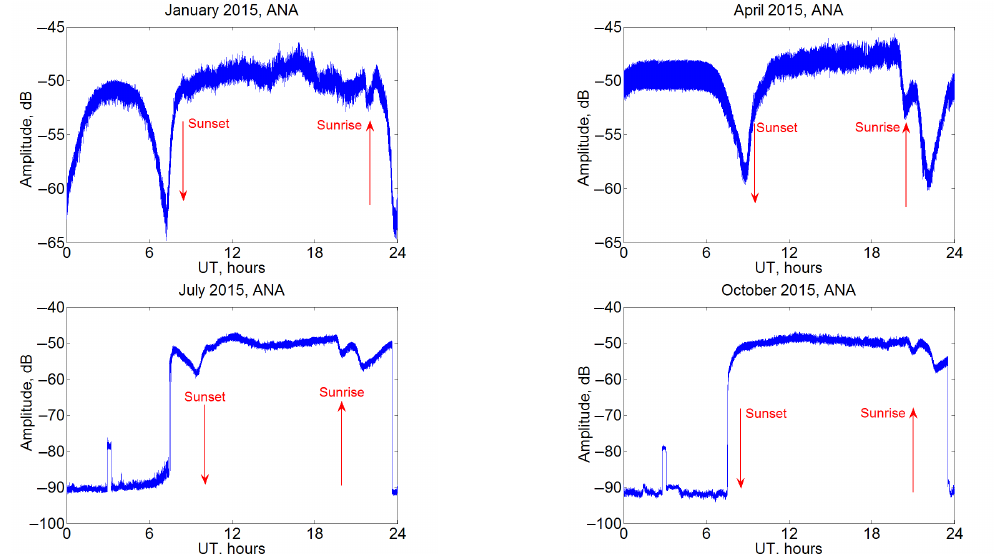
Figure 2. Monthly average variations of JJI VLF amplitudes at the ANA station in January, April, July and October 2015; median values for each second for all days of the month are used for the calculation. Local sunset and sunrise hours are indicated with red